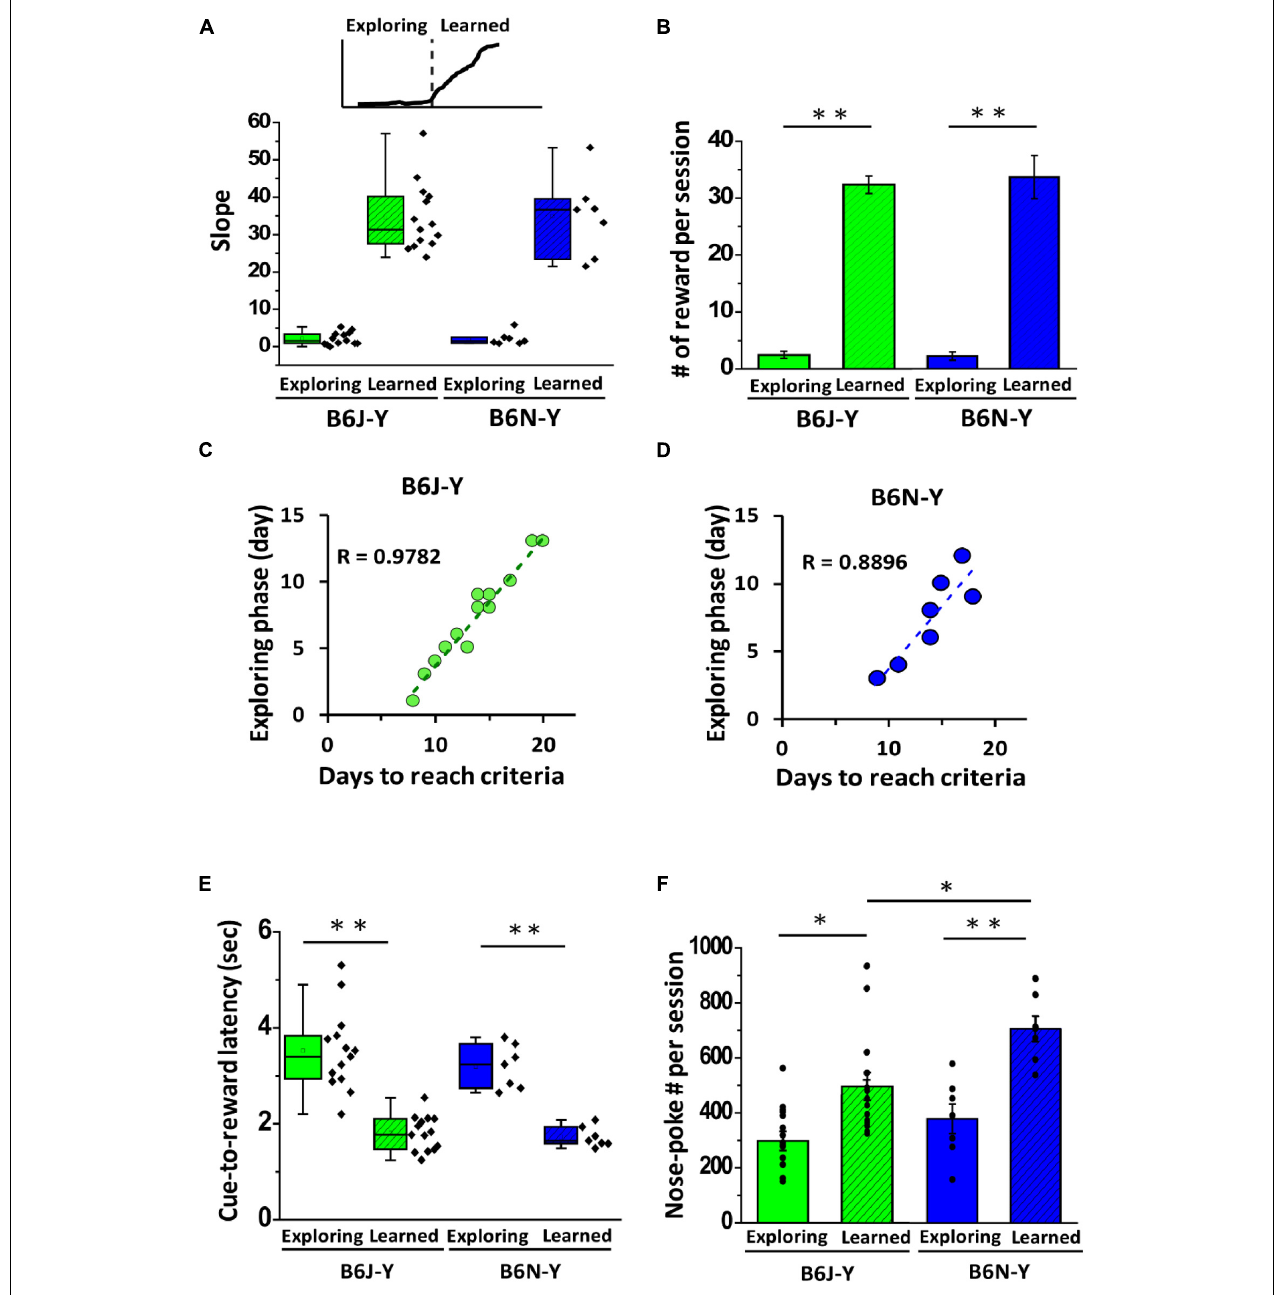
FIGURE 3 | Phasic differences in rule learning of the B6J and B6N mice during young adulthood. (A) Individuals learning curves are characterized by distinct slopes during exploring and learned phase of rule learning, as shown in box plots. (B) Both B6J-Y and B6N-Y mice were able to collect more water rewards during learned phase of rule learning. (C,D) For both B6J-Y and B6N-Y mice groups, the length of rule learning is highly and positively correlated with length of exploring phase. (E) Box plots of cue-to-reward latency (time needed to complete a trial) in exploring and learned phases of B6J-Y and B6N-Y groups. A significant reduction in cue-to-reward latency from exploring to learned phase is seen in both animal groups. (F) Both B6J-Y and B6N-Y mice exhibited higher nose-poke frequency in learned phase than in exploring phase. ∗ p < 0.05, ∗∗ p < 0.01.